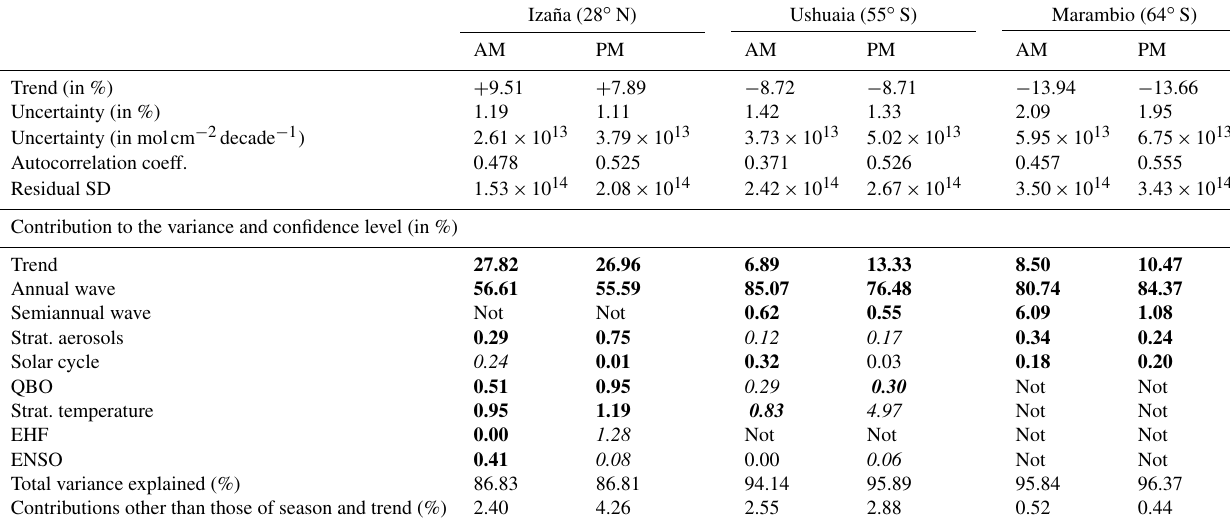
Table 3. Summary of the trend analysis for the DOAS stations. In the lower part, the contribution of each explanatory variable to the total variance is given in %. The colours denote the significance (bold 99%, italic 95% and bold italic 90%). “Not” means it has been excluded from the definite